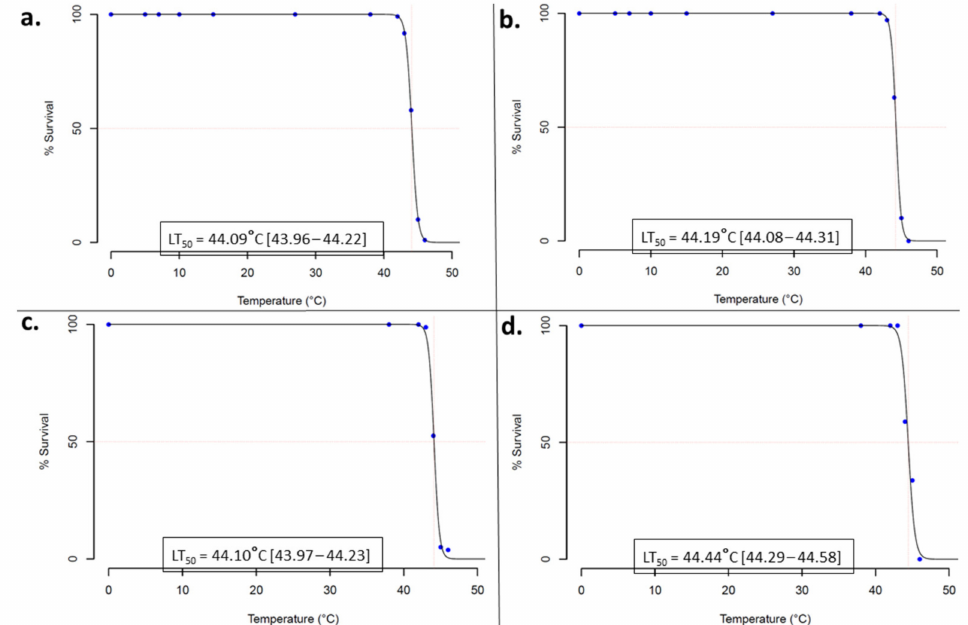
Figure 1. Thermotolerance profile of various populations of Anopheles gambiae s.l. larvae. Dose- response (temperature-course) bioassays for ( a ). Auyo, ( b ). BUK, ( c ). Gamjin Bappa and ( d ). Pantami. LT 50 , the temperature that killed 50% of the larvae are given inside rectangular inset with 95% confidence intervals in square